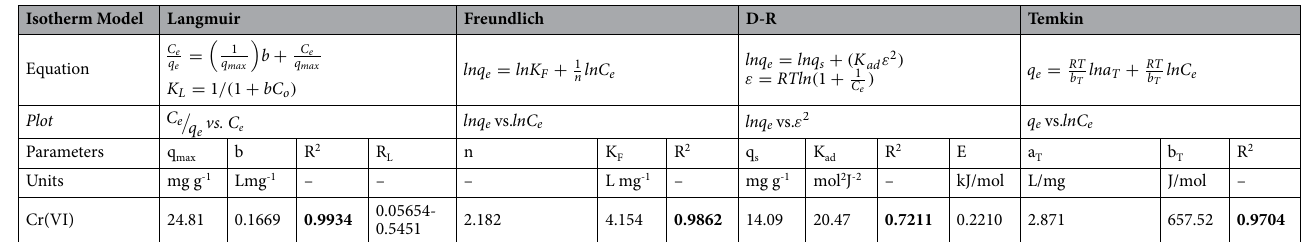
Table 2. Adsorption isotherm models for Cr(VI) using 20 mg Fe 0.75 Cu 0.25 -BDC@Alg-MoO 3 /GO and shaking time = 30 min at pH 3. Significant values are in